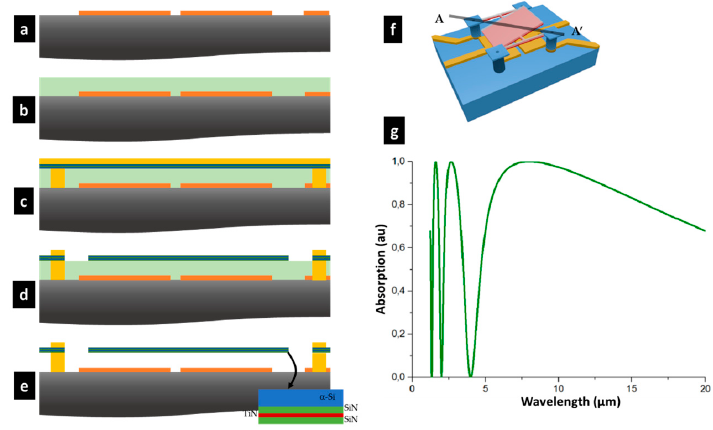
Figure 2. Synopsis of the fabrication process along the cross section AA’: ( a ) Deposition of a 300 nm thick AlCu layer on a silicon substrate/strip lines/reflector wet etching; ( b ) 2 μ m deposition of a polyimide layer; ( c ) Etching of the polyimide layer to build up the metal studs, and deposition of the plate material; ( d ) Definition of the plate; ( e ) Dry etching O 2 plasma release; ( f ) 3D artist view of a pixel; ( g ) Absorption spectrum of the 2 μ m thick micro cavity.